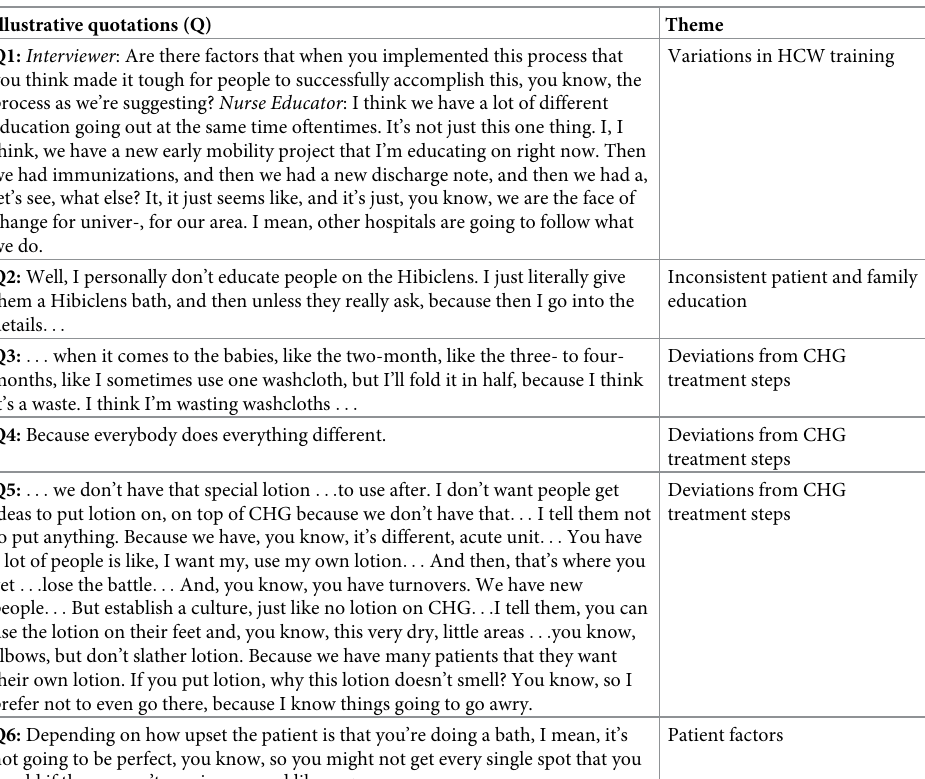
Table 4. Representative